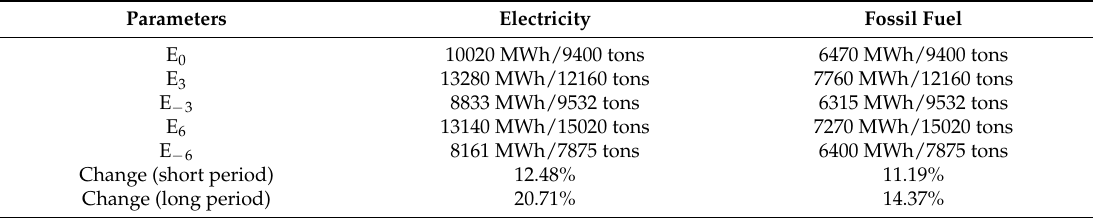
Table 1. Example of data from one of the companies included in the study.